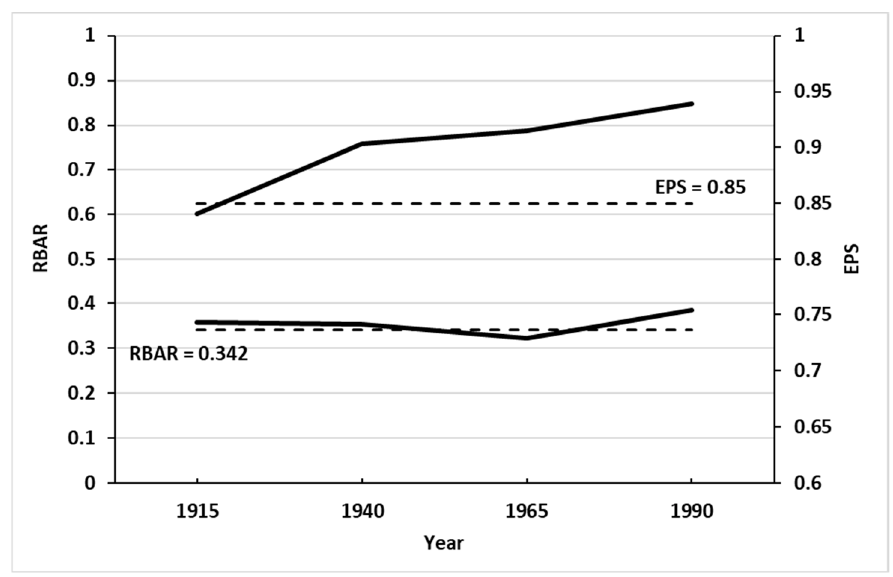
Figure 3. Running RBAR and EPS plots of the Abies borisii-regis chronology based on a 50-year window with 25-year overlaps.